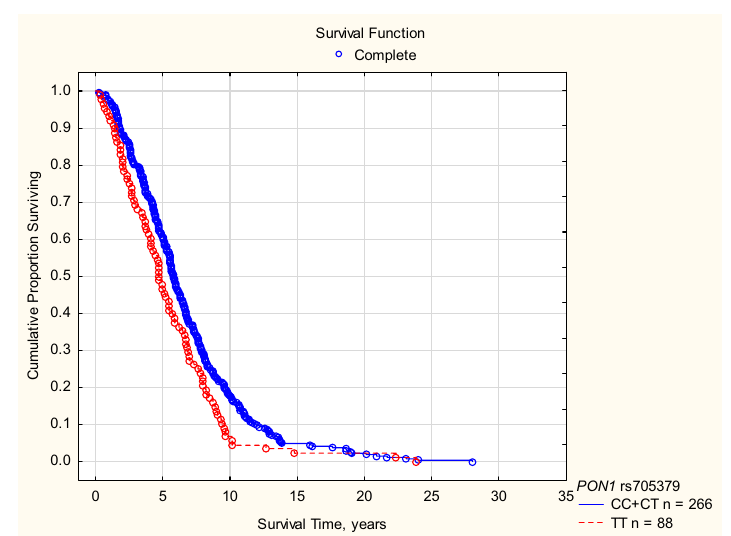
Figure 1. PON1 rs705379 and cumulative proportion surviving for cardiovascular diseases in HD patients. ( a ) All cardiovascular diseases. ( b ) Cardiac diseases. ( c ) Coronary heart disease and its complications. ( a) Log-rank P = 0.033. The Cox proportional hazards regression for rs705379 TT vs. CC + CT: HR 0.784, 95% CI 0.636– 0.966, P = 0.022. ( b) Log-rank P = 0.035. The Cox proportional hazards regression for rs705379 TT vs. CC + CT: HR 0.755, 95% CI 0.592–0.962, P = 0.023. ( c) Log-rank P = 0.021. The Cox proportional hazards regression for rs705379 TT vs. CC: HR 0.639, 95% CI 0.440—0.928, P =